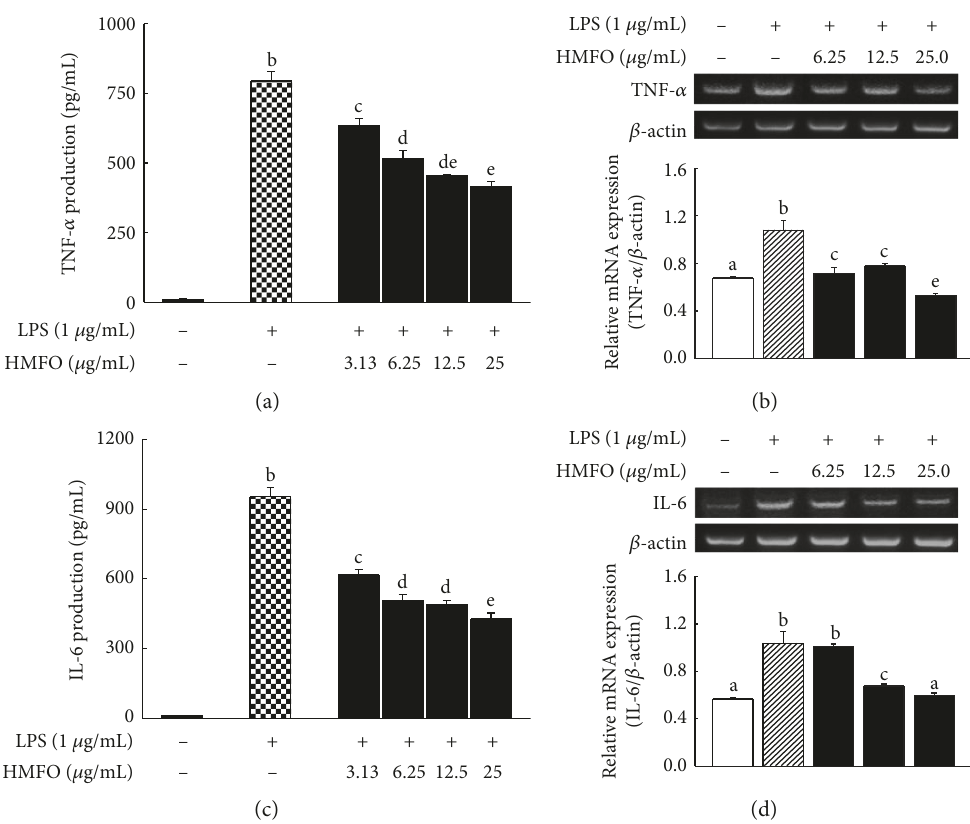
Figure 6: E ff ects of HMFO on LPS-induced proin fl ammatory cytokine production and mRNA expression in RAW 264.7 macrophages. RAW 264.7 macrophages were pretreated with di ff erent HMFO concentrations for 2 h and then stimulated with LPS (1 μ g/mL) for 22h. (a) TNF- α and (c) IL-6 were quanti fi ed with an ELISA kit, according to the manufacturer ’ s protocol. The data are presented as the mean ± SD. Total RNA was isolated, and (b) TNF- α and (d) IL-6 mRNA levels were measured by RT-PCR. Values with di ff erent letters are signi fi cantly di ff erent ( p < 0 05